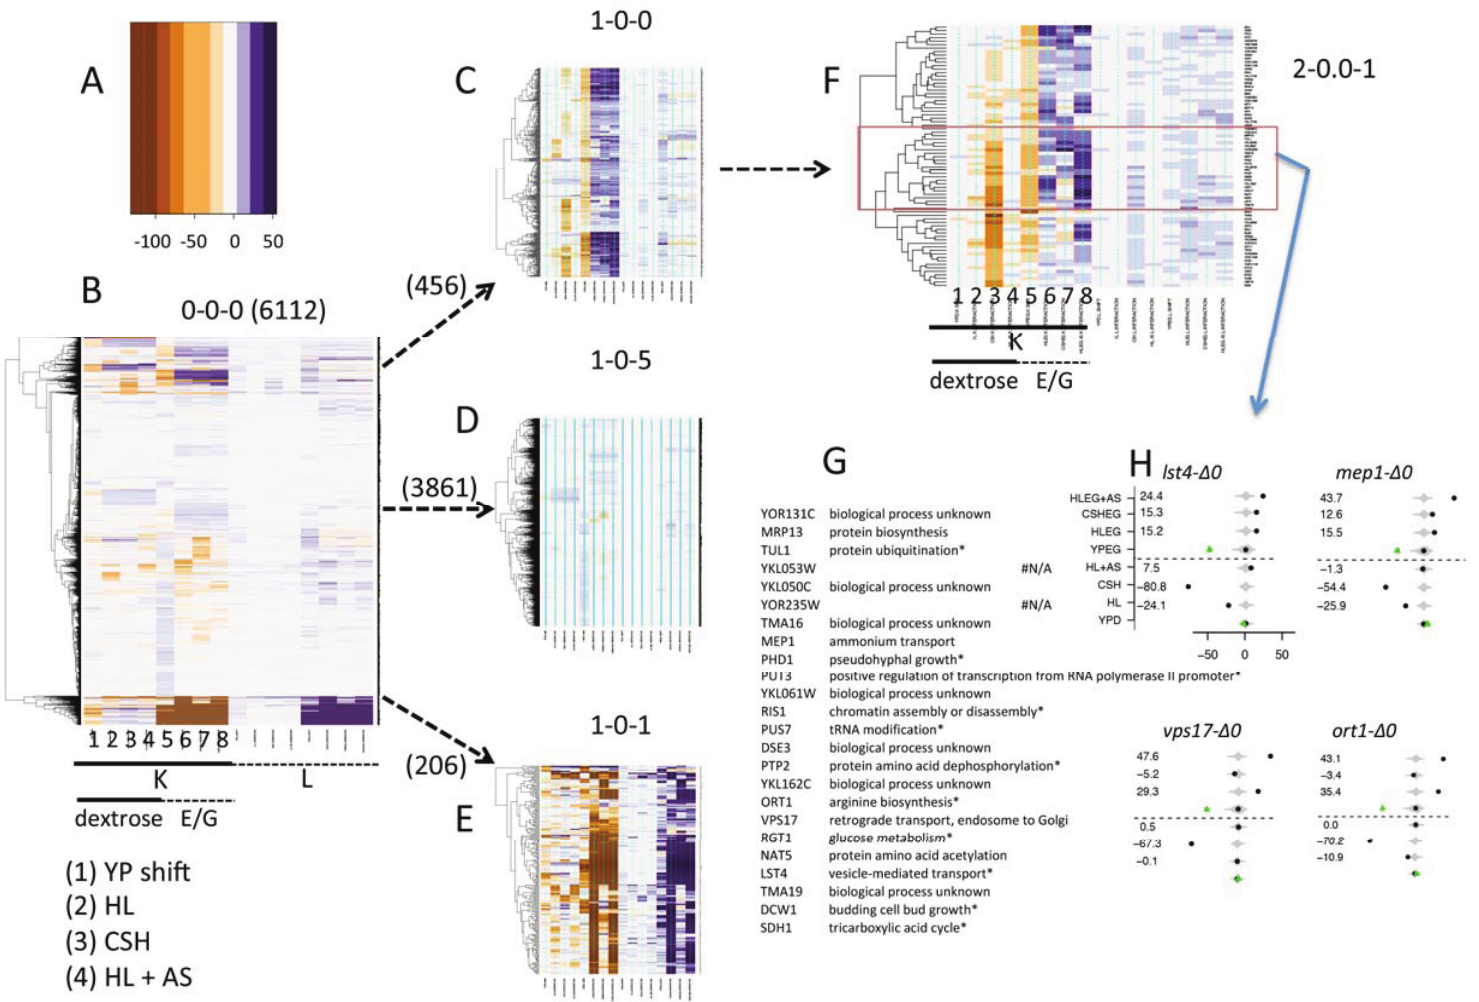
Figure 3. REMc reveals gene X media interaction modules. Q-HTCP was performed for the YKO/KD collection on the indicated media, and interactions were calculated for defined media using YPD or YPEG as a control (see text and methods). REMc was used to mine interaction values derived from K and L for shared patterns. ( A ) A color scale was used to visualize interaction values, which are positive/blue with